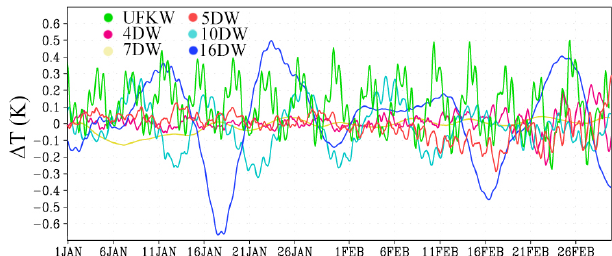
Figure 4. Time series of mean zonal temperature variations due to the inclusion of tropospheric sources of various PWs in the regions of their maximum amplitudes in the MUAM.